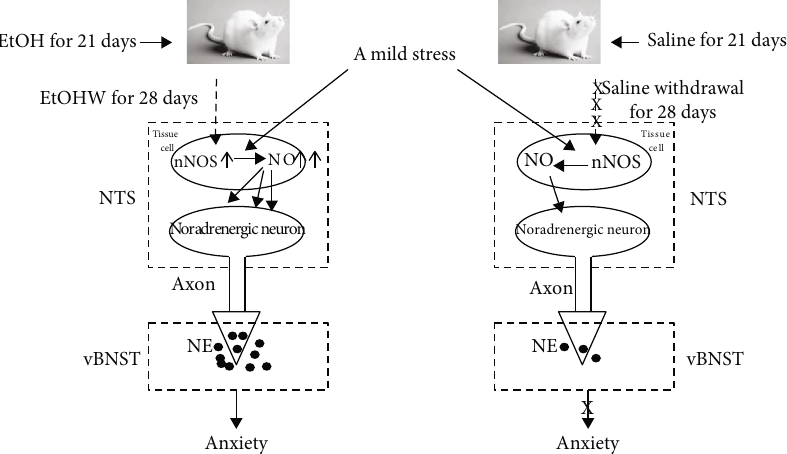
Figure 8: Mechanisms of AMRS-provoking anxiety during protracted EtOHW. EtOH: ethanol; EtOHW: EtOH withdrawal; NO: nitric oxide; nNOS: neuronal NO synthase; NE: norepinephrine; NTS: nucleus tractus solitarius; vBNST: ventral bed nucleus of the stria